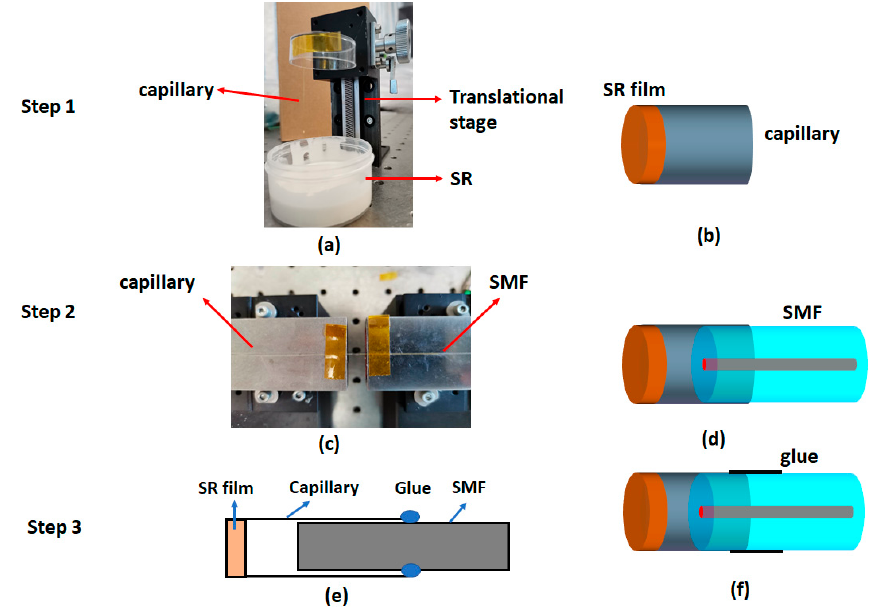
Figure 2. Step by step procedure for the fabrication of the FPI sensor. Step 1: dipping of capillary into the SR solution ( a ) and schematic of the capillary with SR film at its tip ( b ). Step 2: experimental set up for insertion of a SMF into the capillary ( c ) and schematic of the capillary with inserted SMF ( d ). Step 3: schematic of fixing of capillary with SMF using glue ( e ) and resulting probe ( f ), respectively.